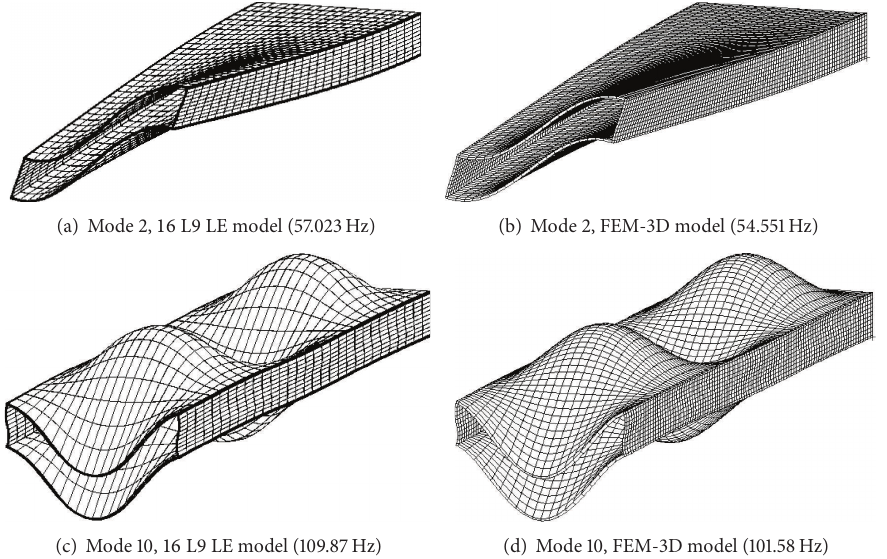
Figure 19: Modal shapes of the hollow-rectangular box beam.